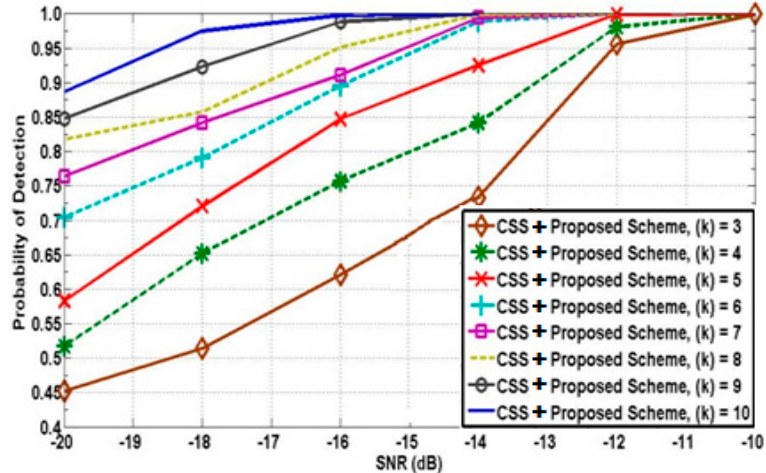
Figure 11. Detection probability versus SNRs under different CRs ( k ) = 3, 4, 5, 6, 7, 8, 9, 10.